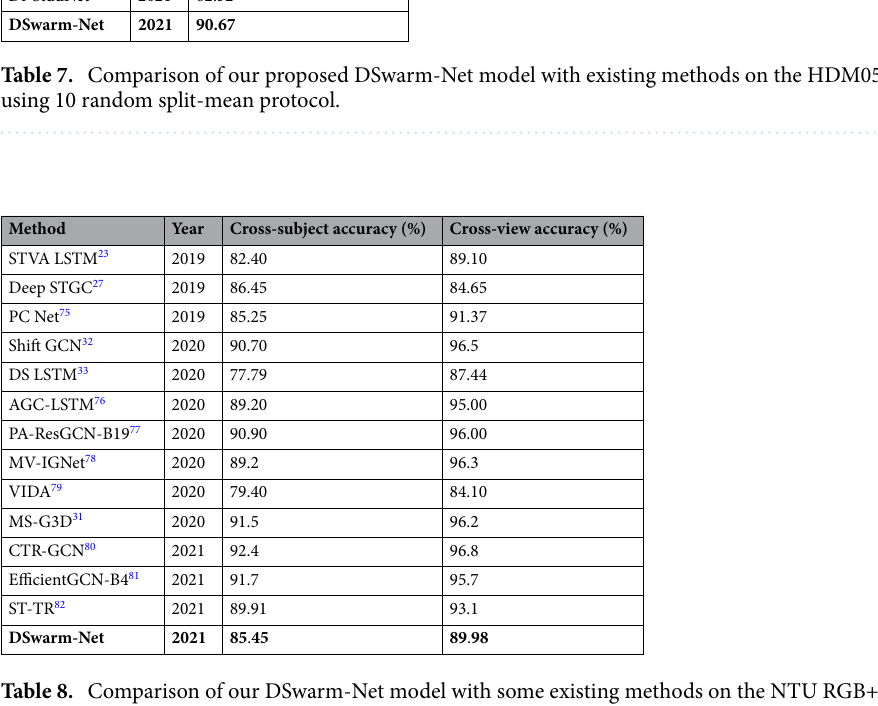
Table 8. Comparison of our DSwarm-Net model with some existing methods on the NTU RGB+D 60 dataset.